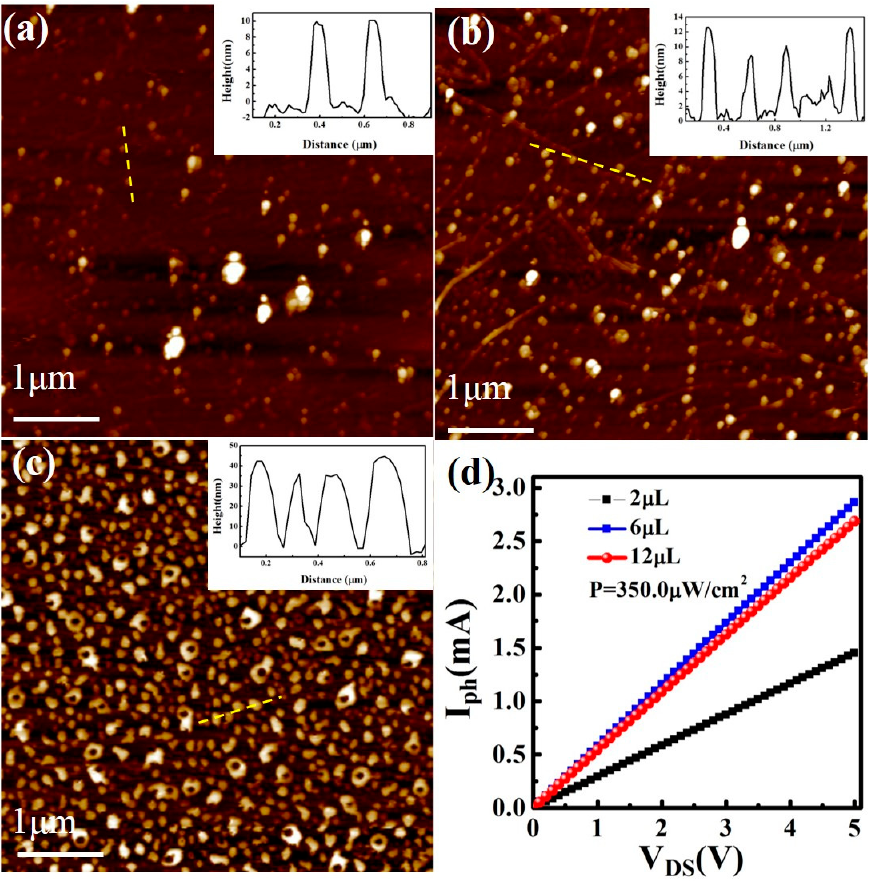
Figure 6. The AFM images of SnSe 2 QDs with different densities ( a ) 2 µL, ( b ) 6 µL, and ( c ) 12 µL. The insets show their height profiles. ( d ) The photocurrents with different SnSe 2 QDs densities at the irradiation density of 350.0 µW/cm 2 .